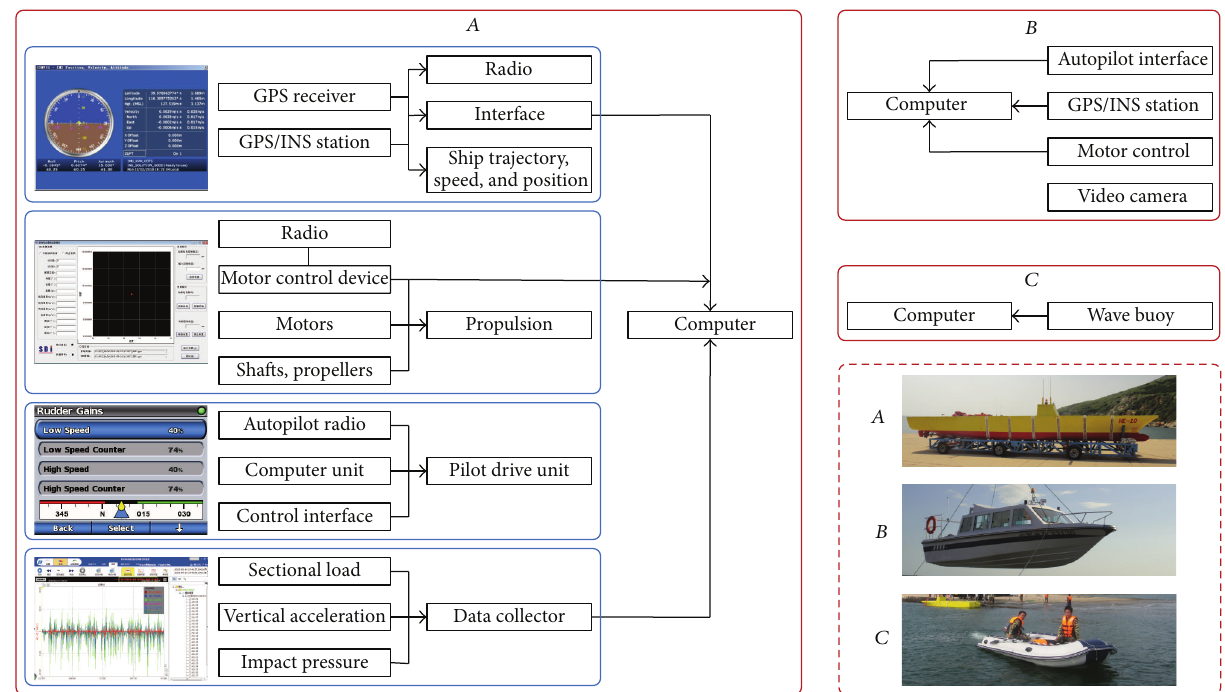
Figure 7: Framework of the overall testing